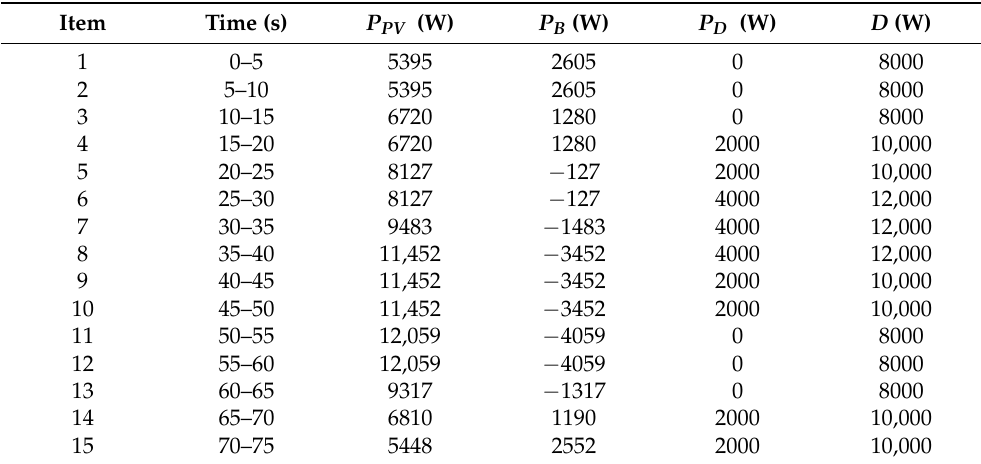
Table 6. Active Power microgrid without